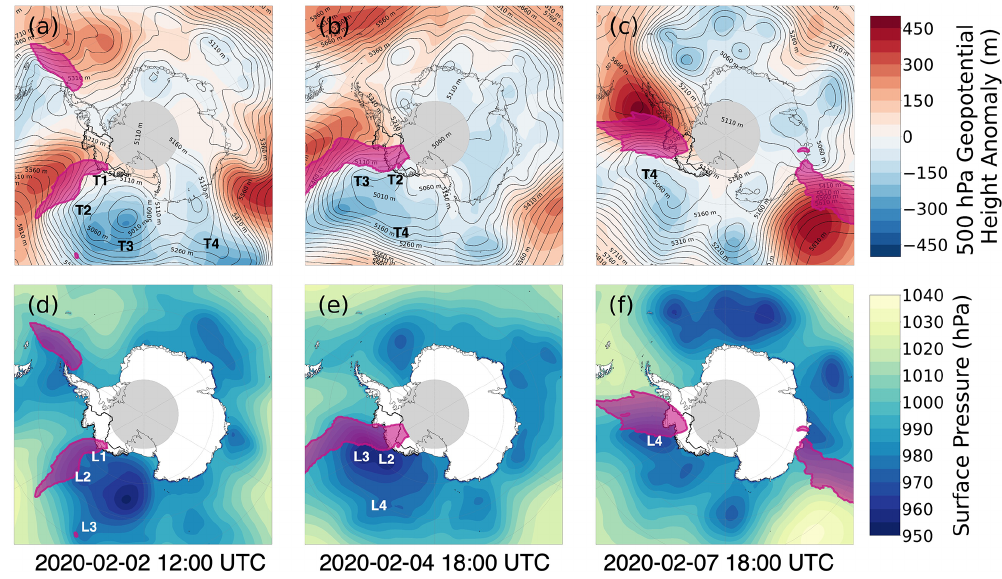
Figure 6. Three ARs make landfall on TG in short succession on (a,d) 2 February, (b,e) 4 February, and (c,f) 7 February 2020. (a– c) MERRA-2 500hPa geopotential heights (contours) and height anomaly (colors) during each AR landfall. (d–f) MERRA-2 surface pressure (colors) during each AR landfall. In each panel, the AR detection catalogue by Wille et al. (2021) indicates the spatial footprint of the ARs in pink. The location of shortwave troughs (geopotential height) and associated nodes in the low-pressure system (surface pressure) are indicated in each panel. Trough 1 (T1) drives Low 1 (L1), T2–L2, T3–L3, and